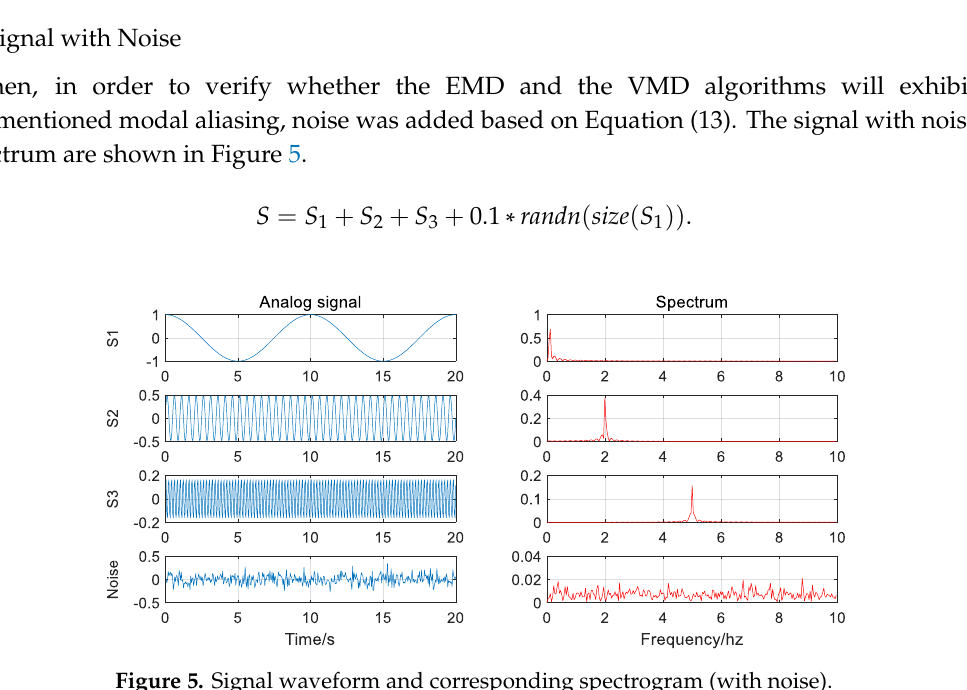
Figure 4. ( a ) The EMD (Empirical Mode Decomposition) decomposition results of the signal (without noise); ( b ) The VMD (Variational Mode Decomposition) decomposition results of the signal (without noise).